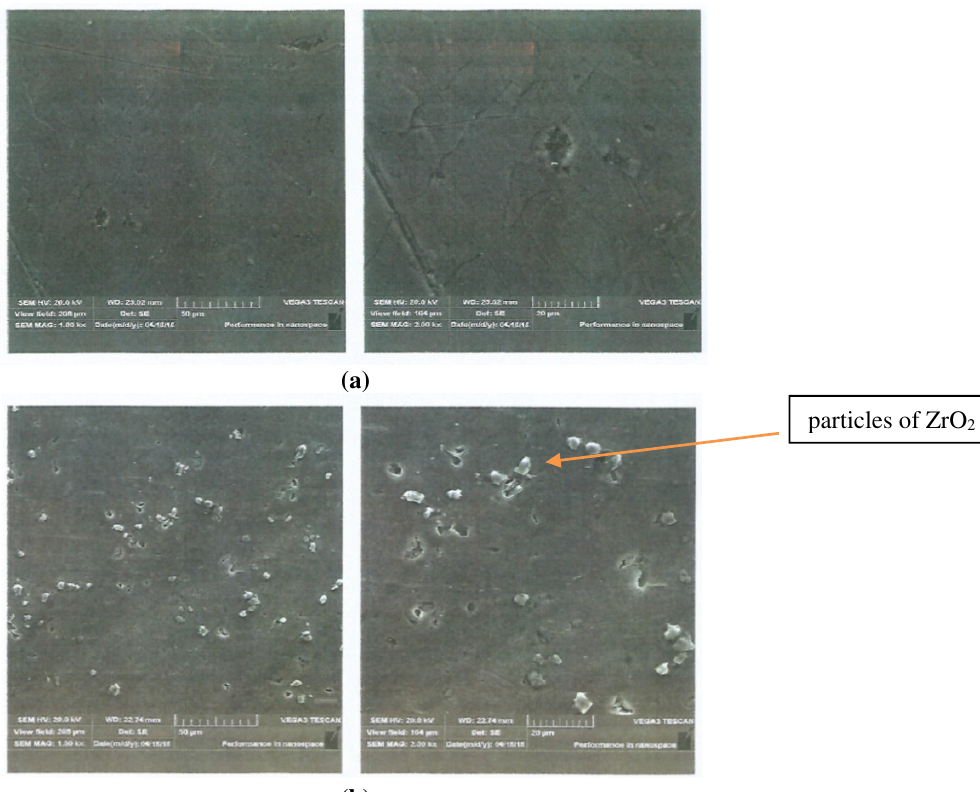
Fig. 7. (a) SEM micrograph of 7049AA as received at different magnification 50 and 20 μ m respectively (b)SEM micrograph of composites fabricated of 7049AA with 4wt% ZrO 2 at different magnification 50 and 20 μ